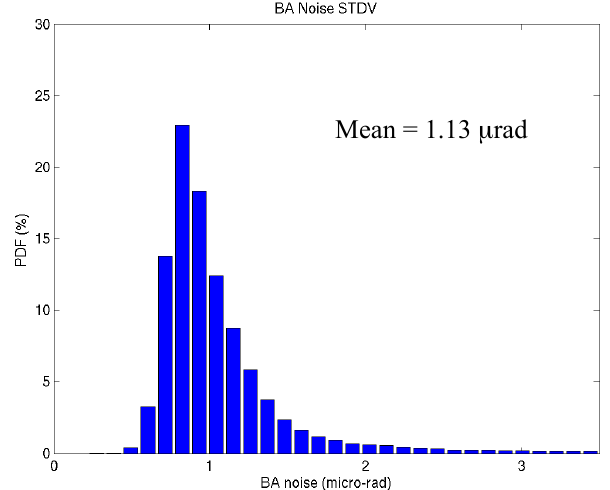
Fig. 14. Distribution of standard deviation of bending angle noise for each occultation between 60 and 80km heights for ∼ 79000 Metop/GRAS profiles from July–December